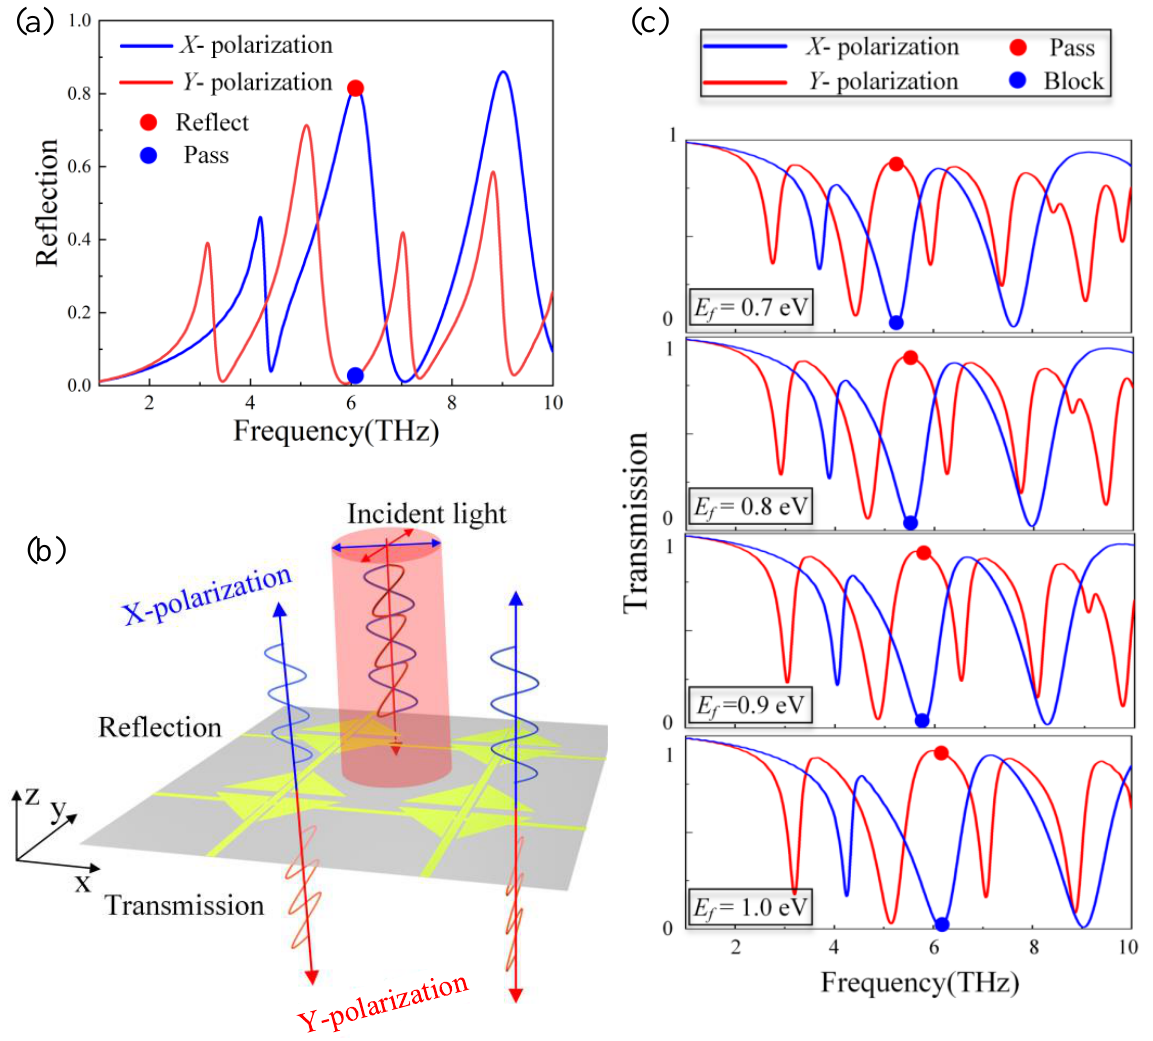
Figure 6. ( a ) Reflection spectrum of x - and y -polarized lights. ( b ) Operating schematic of PBS. ( c ) Frequency points of PBS operation at different Fermi energy levels of graphene.